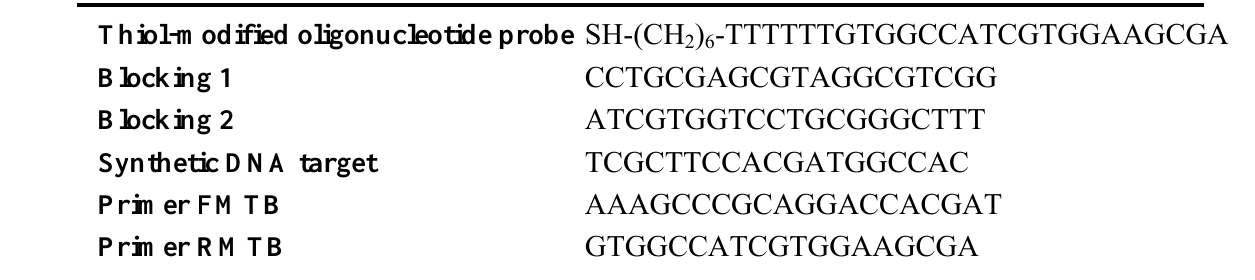
Table 2. The designated oligonucleotides for development of piezoelectric DNA-based biosensor.